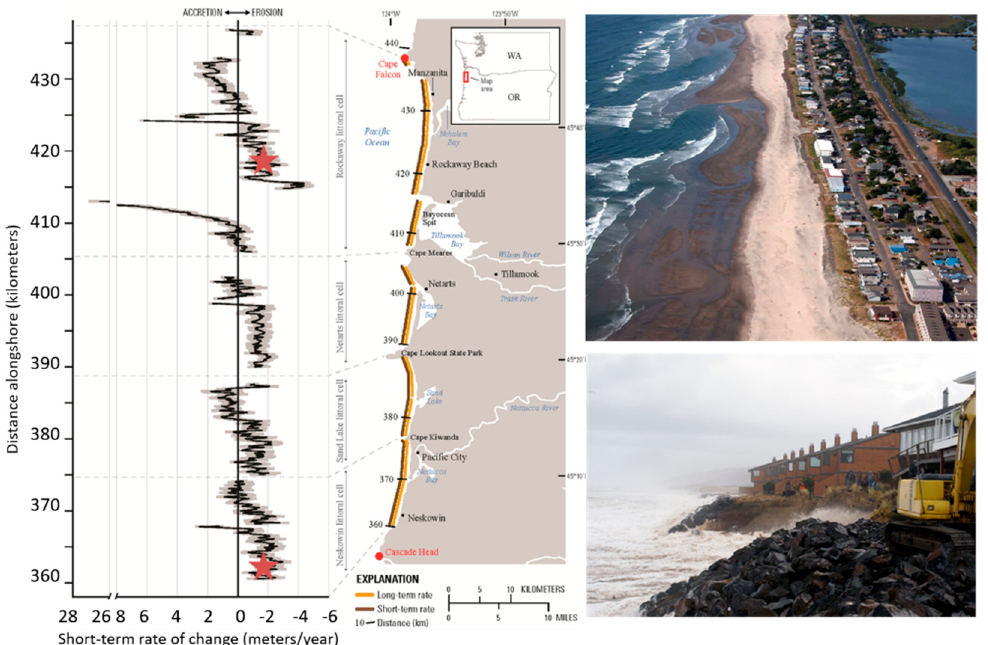
Figure 1. Left. Tillamook County, OR. Multidecadal shoreline change rates were computed between 1967 and 2002 (after [40]). Red stars represent the locations of the two photographs on the right (top—Rockaway Beach, OR and bottom—Neskowin, OR). Both communities are experiencing relatively high shoreline erosion rates (>1.0 m/year), are therefore exposed to coastal change and flood hazards, and have responded via the construction of riprap revetments.